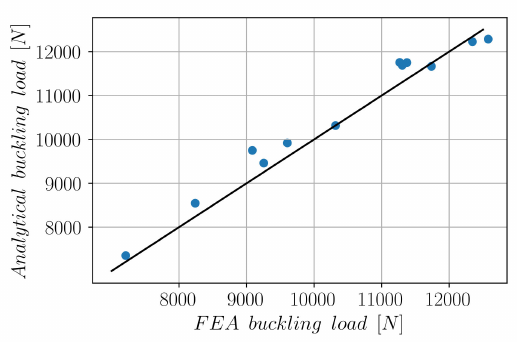
Figure A3. Correlation of analytical and finite element